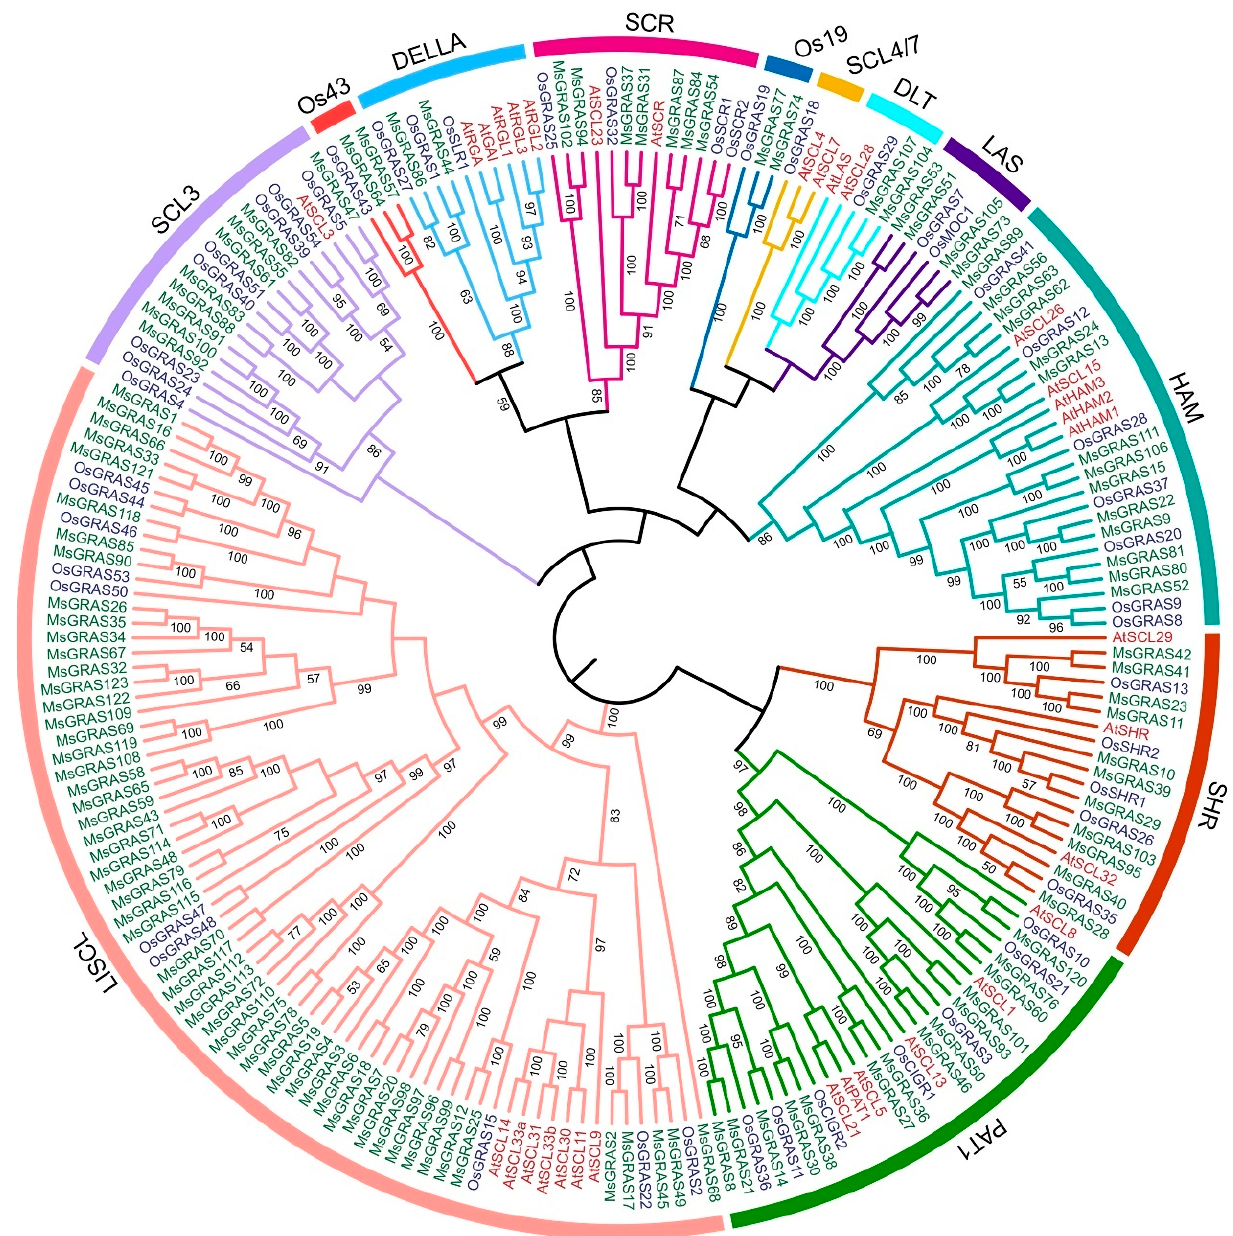
Figure 2. Phylogenetic relationships of GRAS proteins in M. sinensis , Arabidopsis, and rice. The un-rooted phylogenetic tree was generated by neighbor-joining (NJ) method with 1000 bootstrap replicates. Proteins were clustered into 12 clades and illustrated by specific colors belonging to the same subfamily. Bootstrap values larger than 50% were shown. GRAS members from M. sinensis , Arabidopsis, and rice are indicated with green, red, and blue colors, respectively.